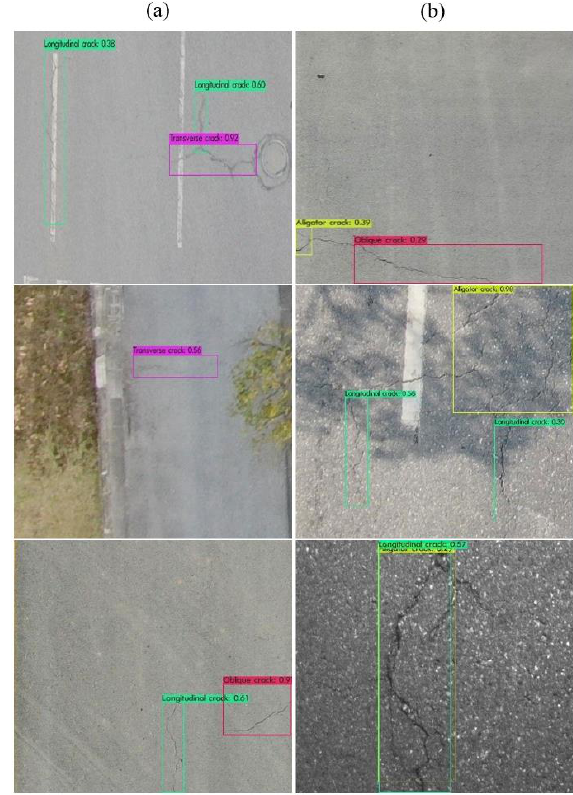
Figure 6 . Some samples of the model's (a) ability and (b) inability in crack